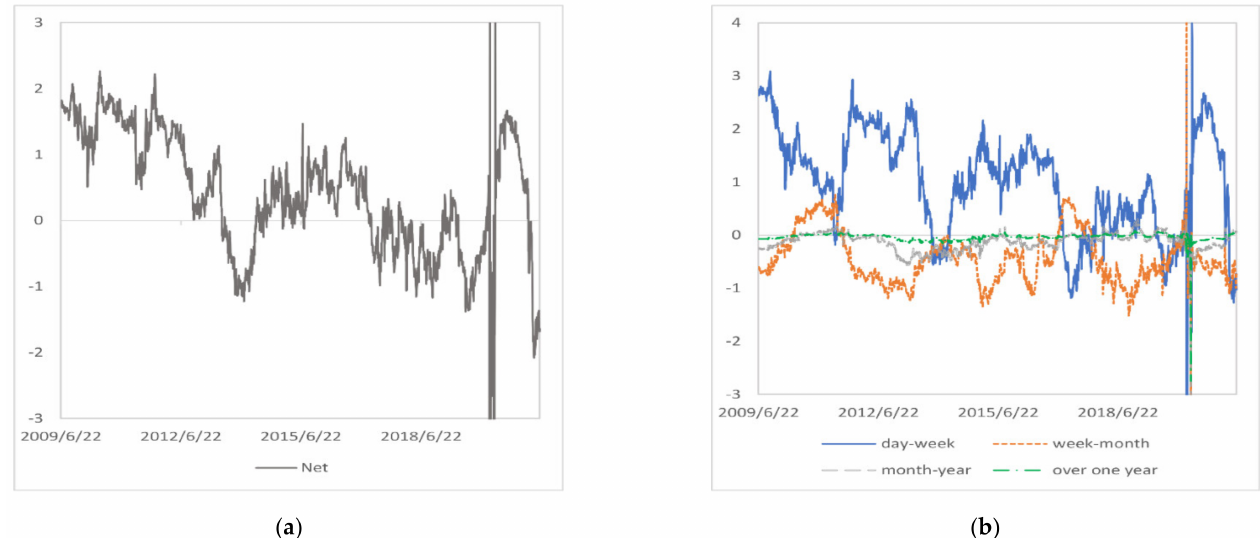
Figure 10. Net directional connectedness of NEX in the price return system. ( a ) net directional connectedness. ( b ) frequency decomposition of net